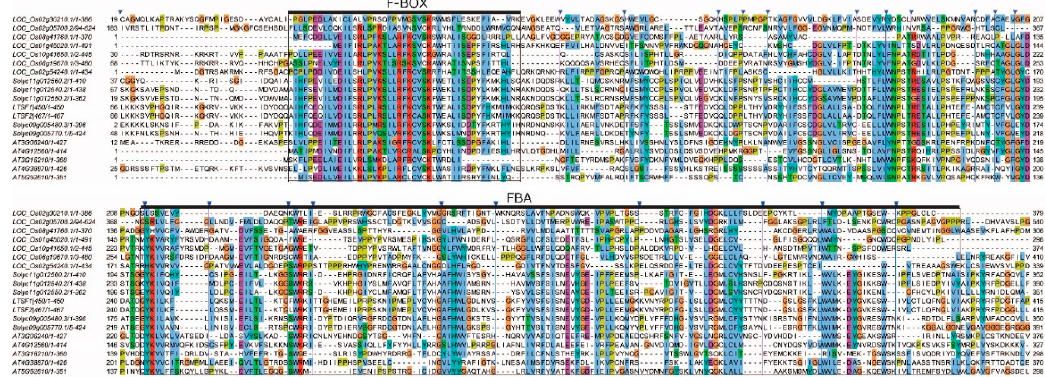
Figure 1. Multiple-sequence alignments of two low-temperature-sensitive F-box (LTSF) proteins, LTSF1 and LTSF2, in pepper (‘No.3341’) with their homologs in Arabidopsis , tomato, and rice. The predicted F-box and F-box-associated (FBA) domains are indicated above the alignment. Amino acid (AA) residues are colored according to ClustalX color code using Jalview tool.